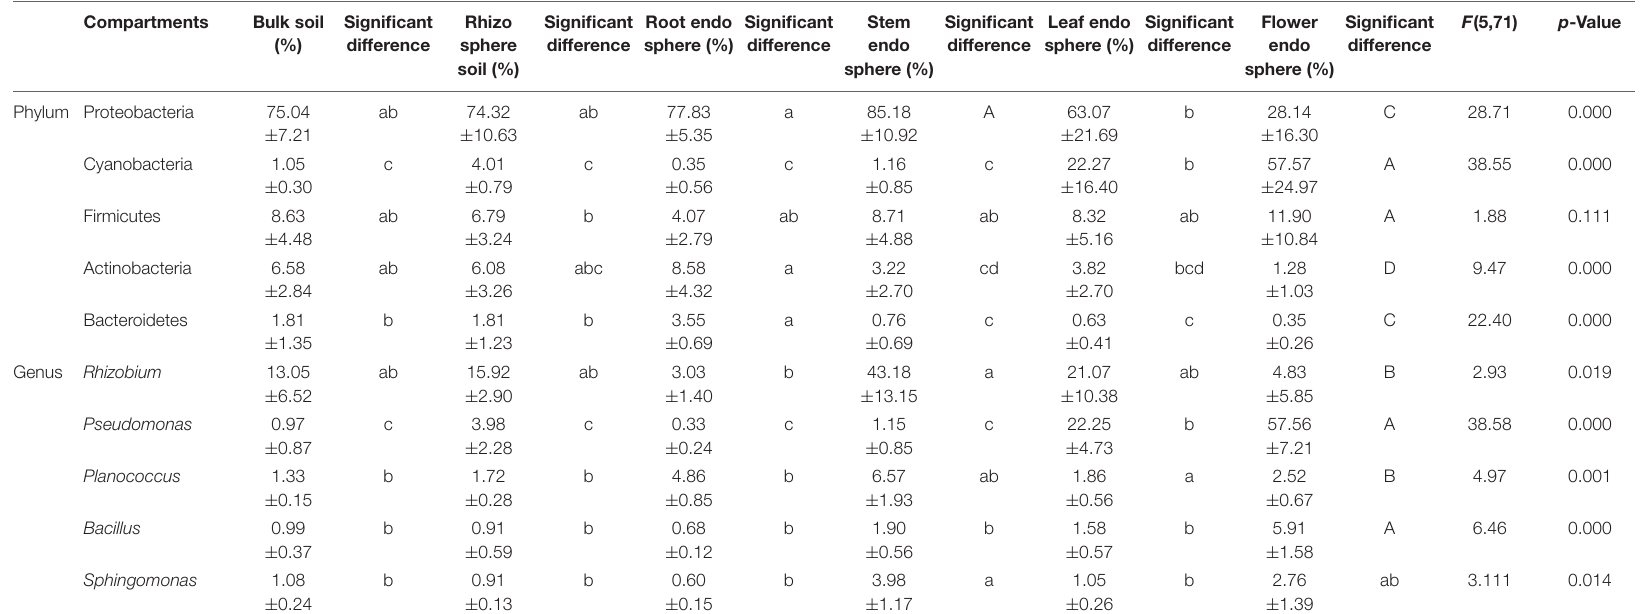
TABLE 1 | The top five most abundant bacterial communities within compartments in hemp plants ( x ± SD). Compartments Bulk soil